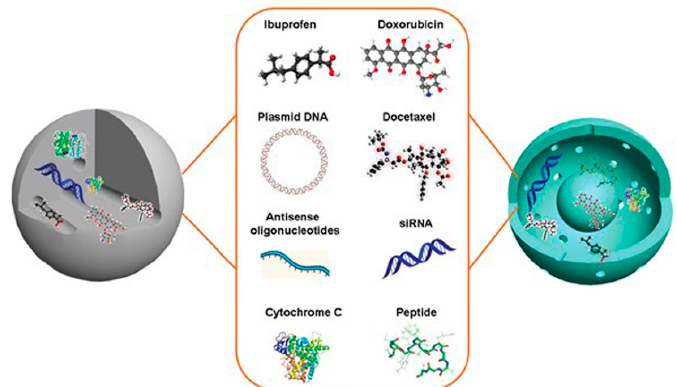
Figure 4. Mesoporous silica nanoparticles as drug delivery systems for various therapeutic agents including drugs (ibuprofen, doxorubicin and docetaxel), therapeutic genes (plasmid DNA, antisense oligonucleotides and siRNA), and therapeutic proteins and peptides. Reprinted with permission from [79].